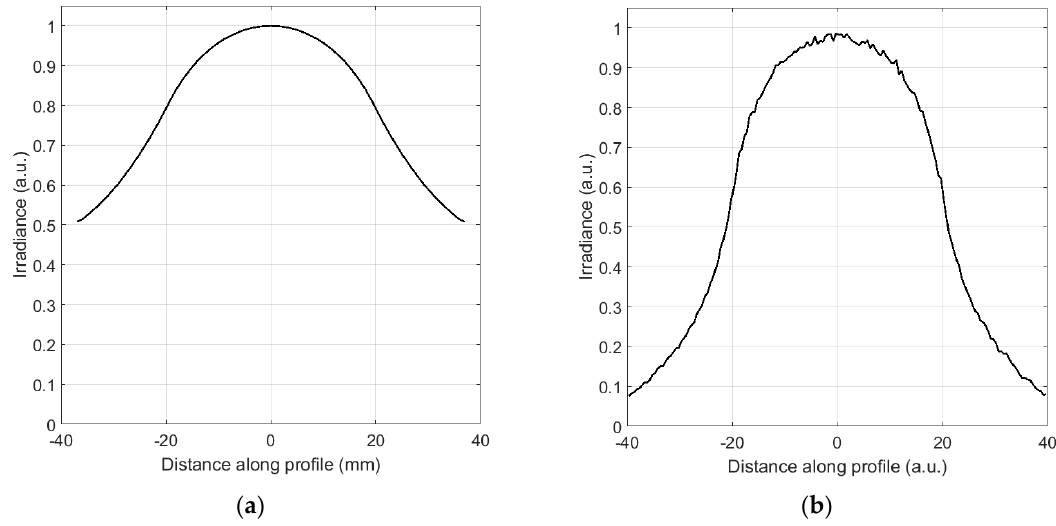
Figure 11. Central irradiance profile of distributions of Figure 10: ( a ) flowline computation; ( b ) raytrace